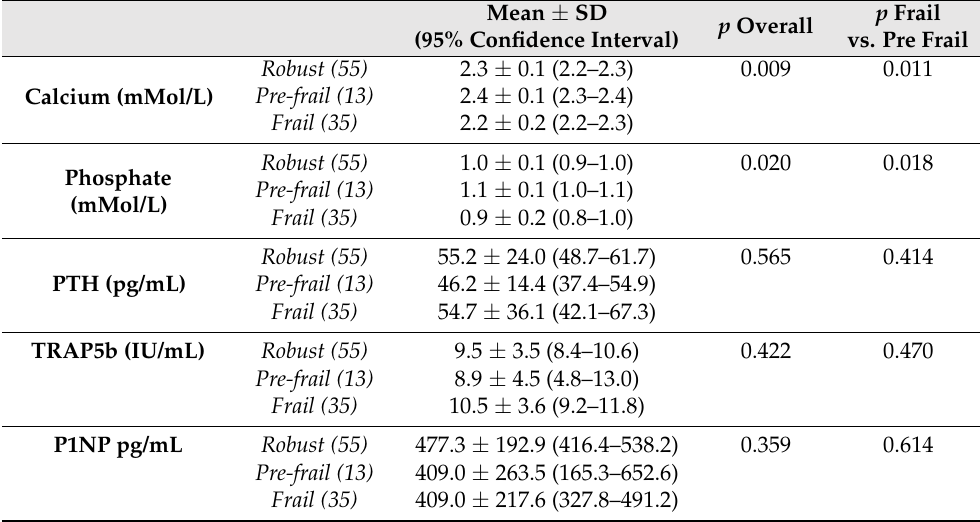
Table 5. Bone health amongst the subjects classified according to the FP criteria. Mean and SD with CI are shown, and the p -values were calculated with one-way